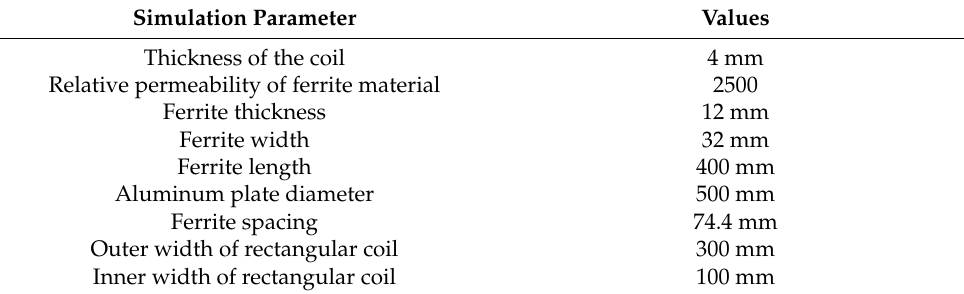
Figure 8. Dimensioning diagram of the primary side of the rectangular structure transformer in 2-D. Table 3. Key parameters of the rectangular structure